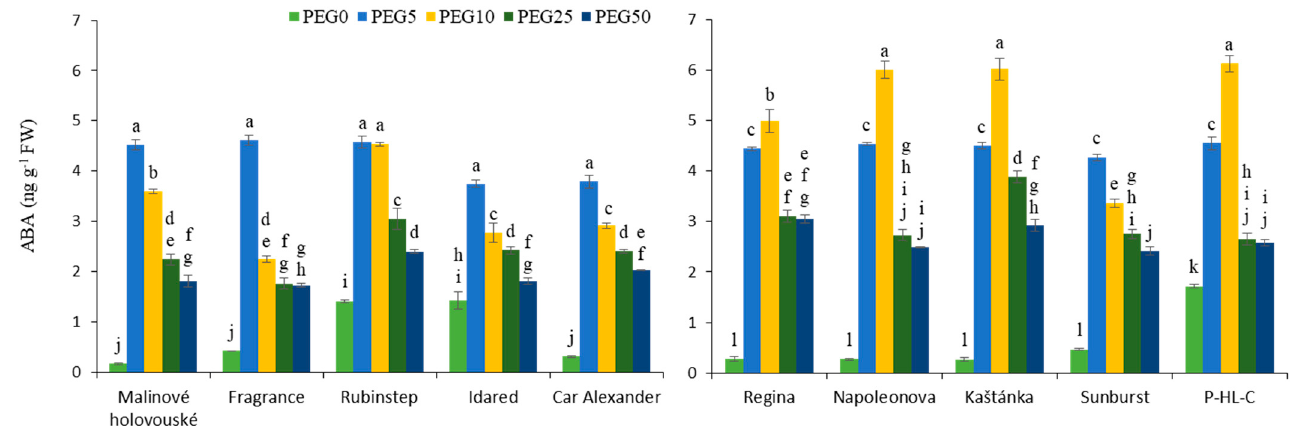
Figure 7. Effect of PEG-6000 concentration on abscisic acid content ABA (ng g − 1 FW) for in vitro culture of apple ( left ) and cherry ( right ) cultivars. Error bars represent standard deviation (SD). Values within column, followed by the same letter(s), are not significantly different according to Tukey’s test ( p < 0.05).